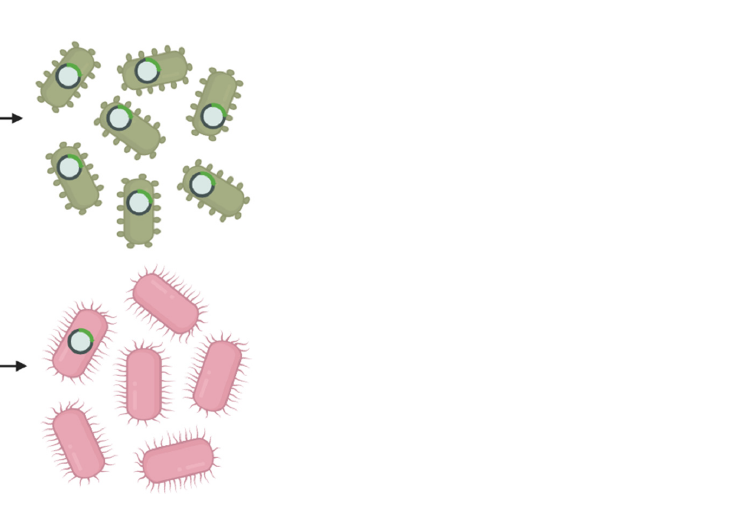
Figure A1. The effect of ORI compatibility and incompatibility on plasmid persistence. In part ( A ), the ORI on the plasmid is compatible with the bacterial replication machinery, so in every bacterial replication cycle the plasmid is replicated as well and therefore is inherited to the daughter cells of the bacterium. On the flipside, in figure ( B ) the endogenous replication machinery is incompatible, leading to plasmid loss over time.